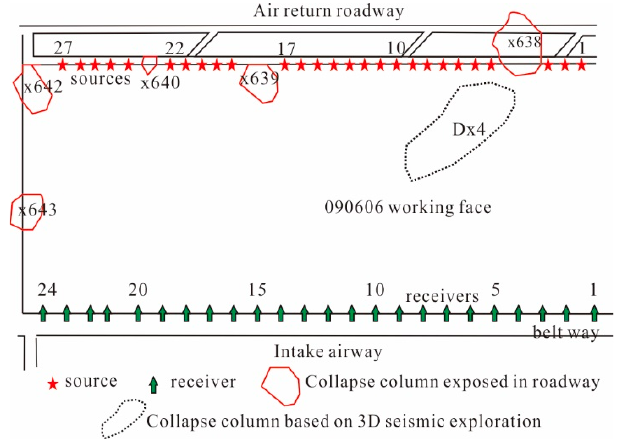
Figure 4. In-seam seismic observation system on the working face. The red stars mark source point locations, and the green arrows mark the receiver point